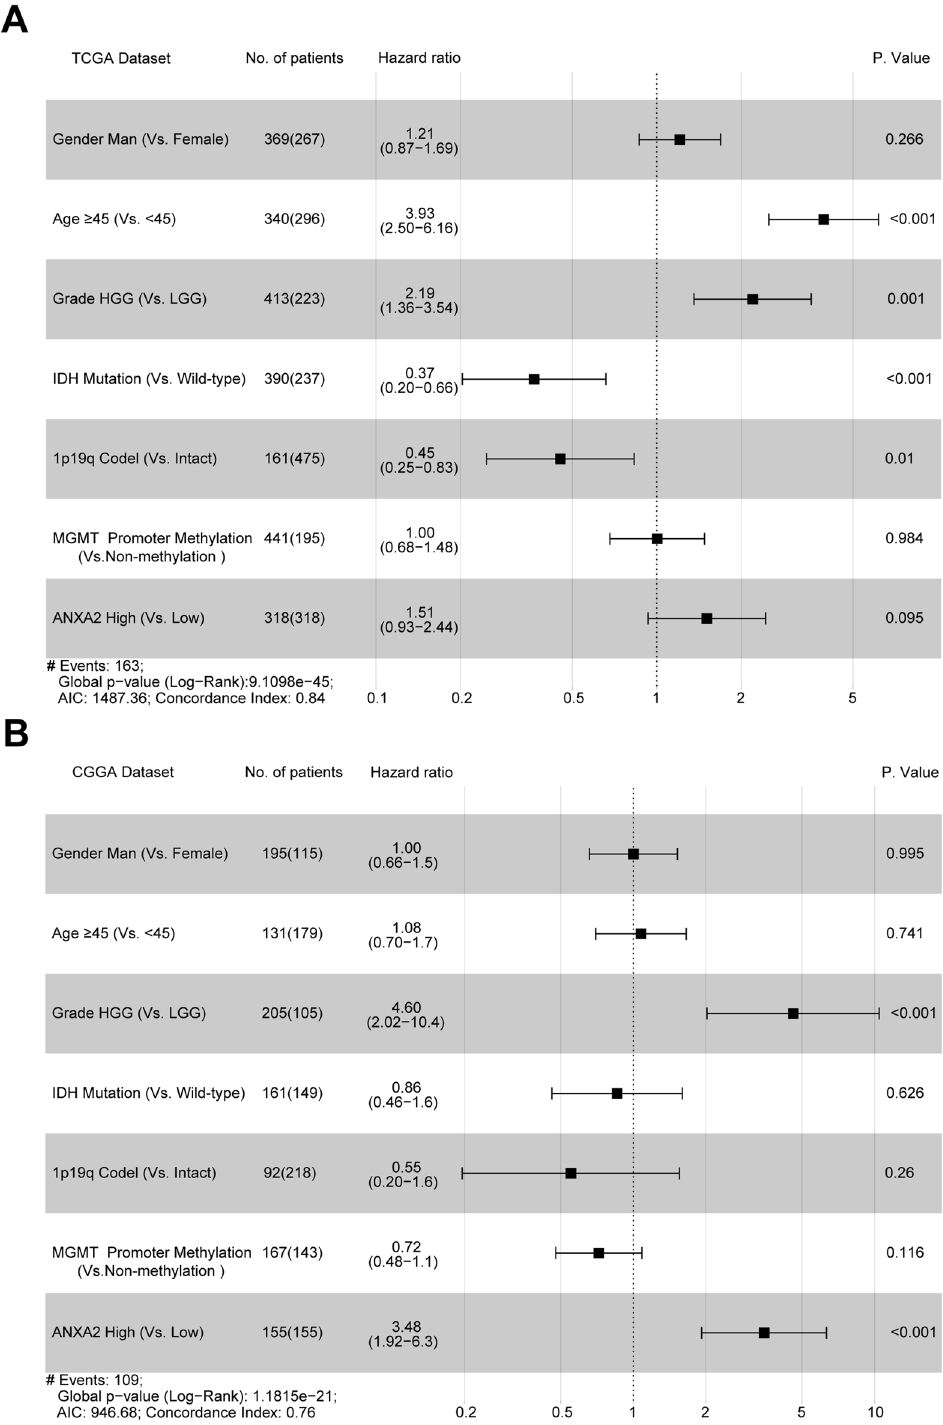
Figure 3. Forest plot of hazard ratios for overall survival rates assessed by ANXA2 and clinicopathological factors. ANXA2 was an independent prognostic factor after adjusting for age, grade, IDH status, 1p19q status and MGMT status in the TCGA ( A ) and CGGA ( B )